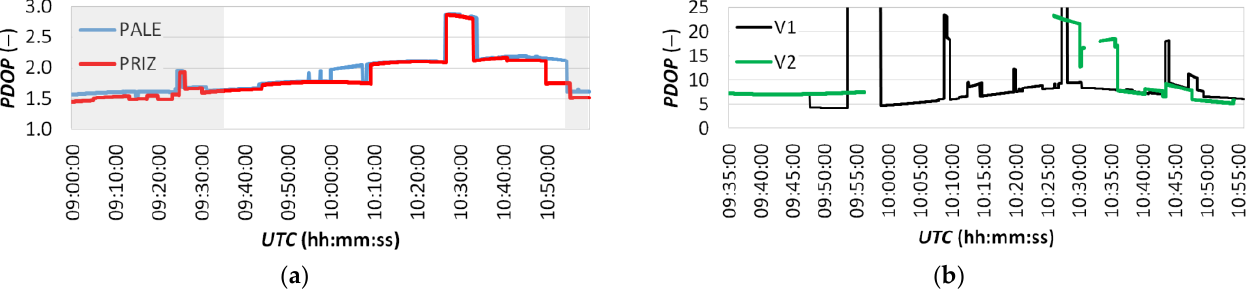
Figure 4. PDOP times series: ( a ) CORS PALE and PRIZ (blue and red lines, respectively); ( b ) V1 and V2 reference landmarks (black and green lines, respectively). Non-overlapping times between the permanent stations and the landmarks' acquisitions are shaded in grey.